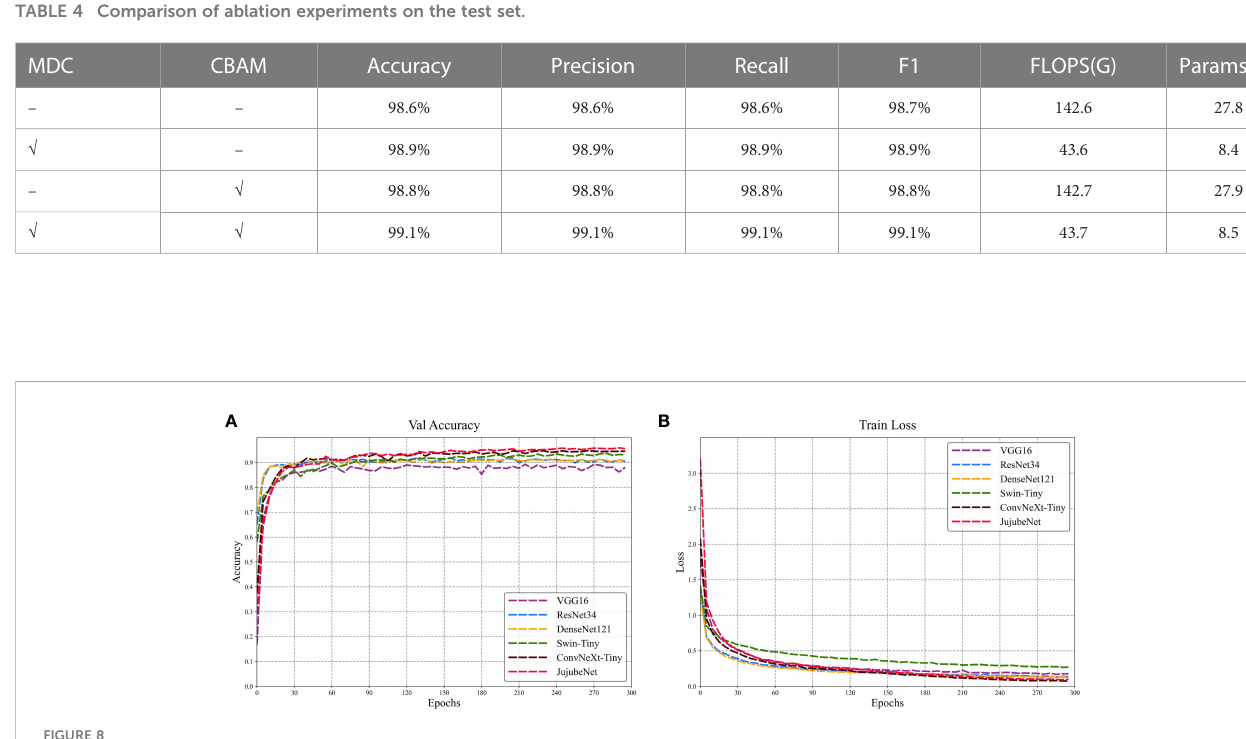
FIGURE 8 Training and validation of each model on the ‘ Jujube2000 ’ dataset. (A) Trend of the validation accuracy curve of the model with the number of epochs. (B) Trend of the training loss curve of the model with the number of epochs. Colors denote corresponding models.